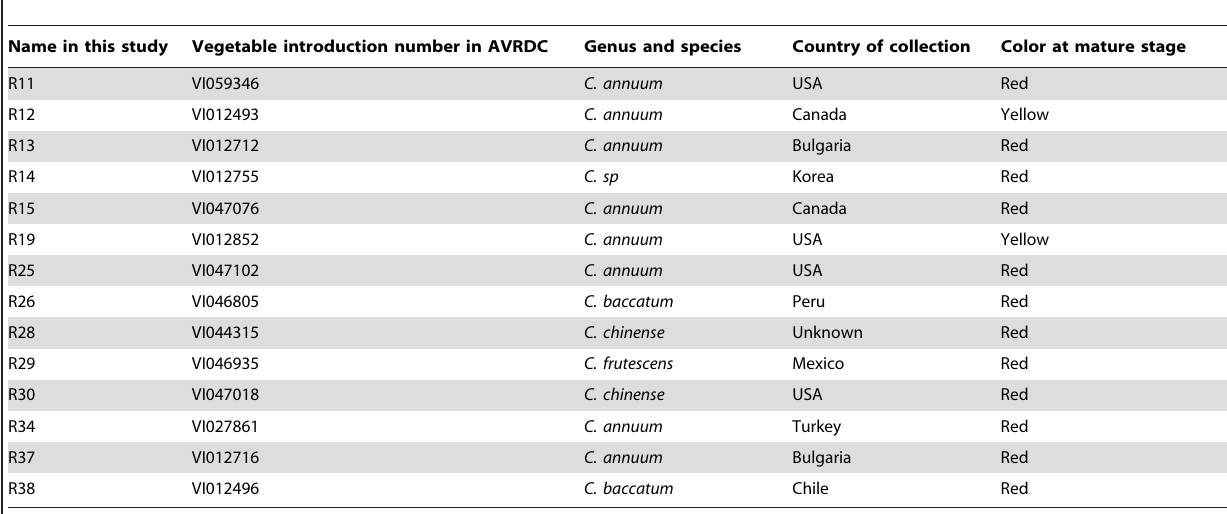
Table 1. Descriptive characteristics of pepper cultivars, developed by the Asian Vegetable Research and Development Center (AVRDC-The World Vegetable